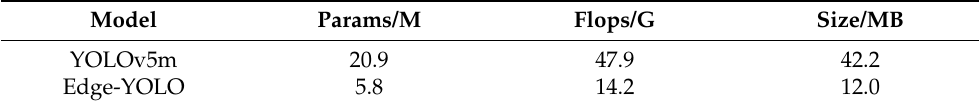
Table 1. Comparison of lightweight improvement effects.